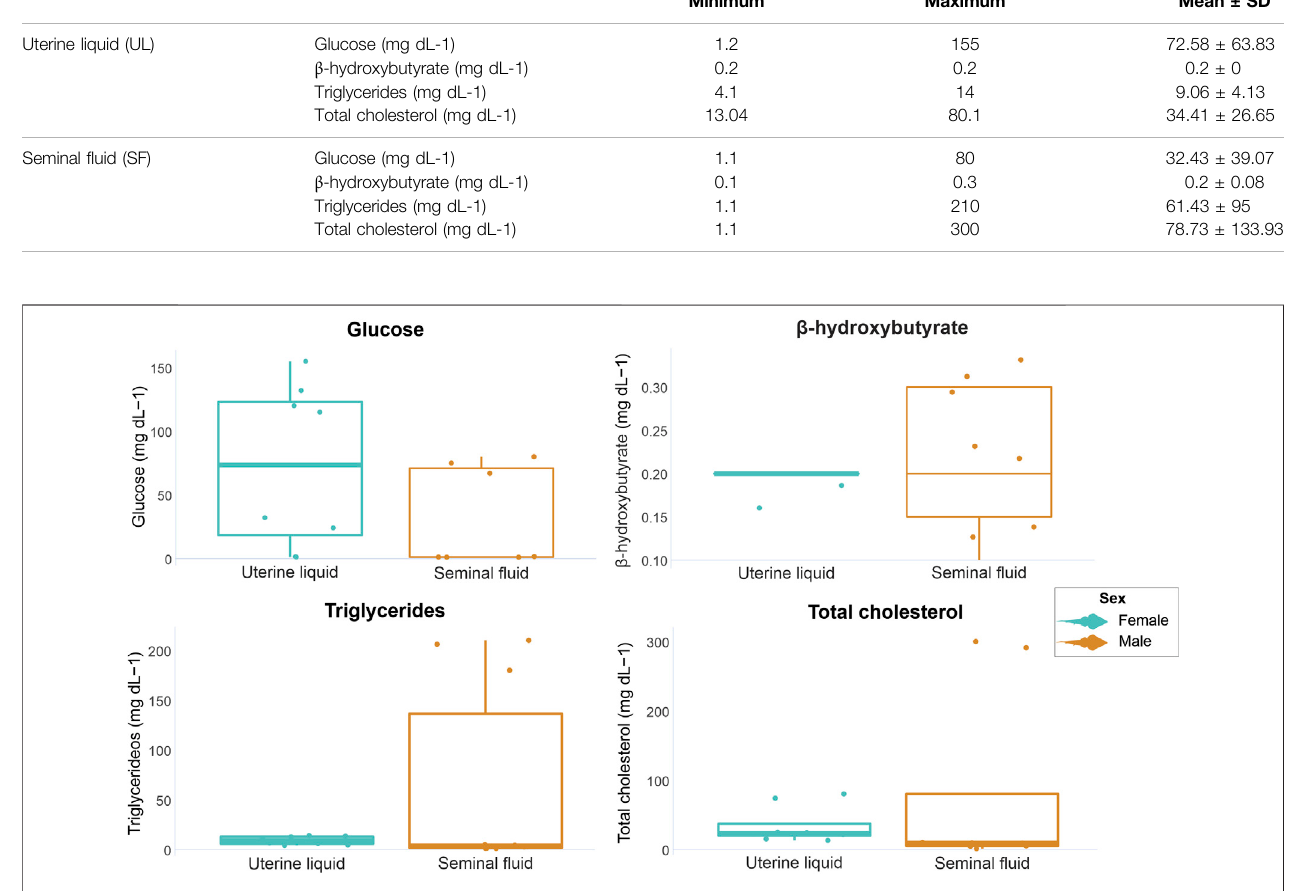
FIGURE 1 | Graphical representation of P. horkelii energetic marker concentrations in the uterine liquid (UL) of pregnant females (light blue boxplots) and in the seminal fl uid (SF) of sexually active males (during the copulation phase) (orange boxplots).